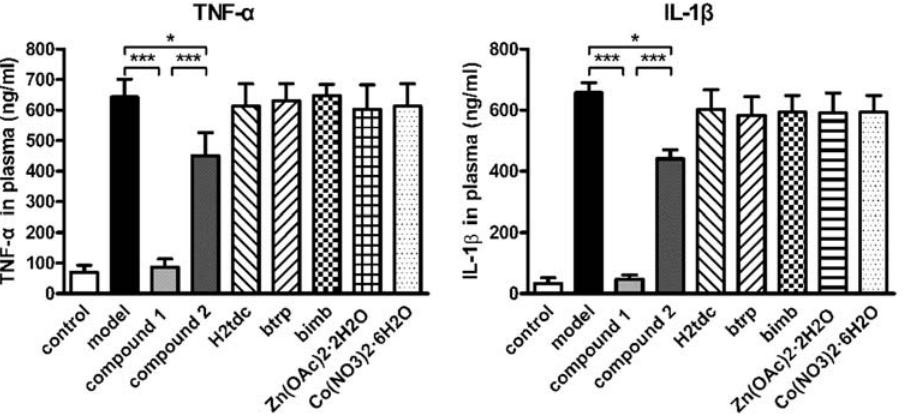
Figure 5: The inhibited release of the TNF - α and IL - 1 β in the gingival crevicular fl uid after compound treatment. The periodontitis rat model was constructed, afterwards treated by compound 1 or 2 at the consistence of 5 mg/kg. The ELISA was carried out to determine the TNF - α and IL - 1 β content in the gingival crevicular